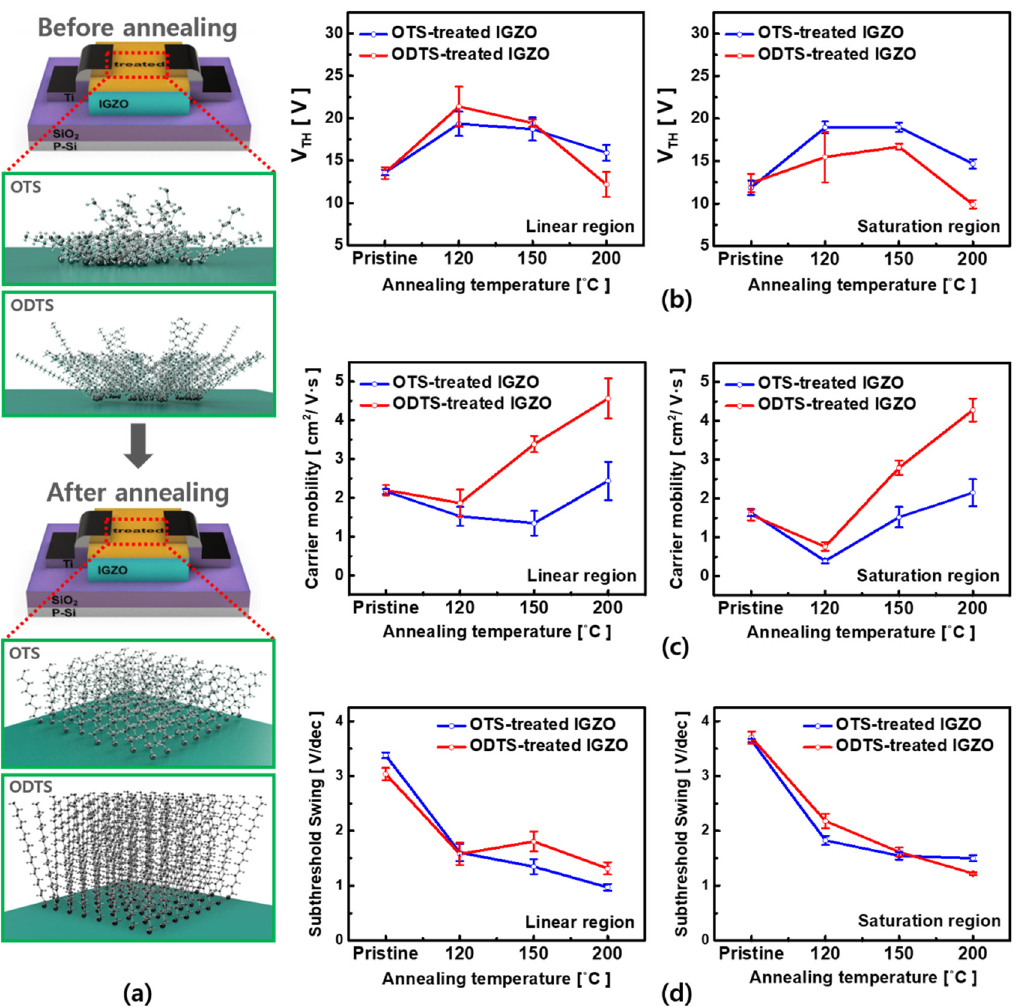
Figure 4. ( a ) Structural changes in the carbon chain according to heat treatment (annealing); structures are aligned after